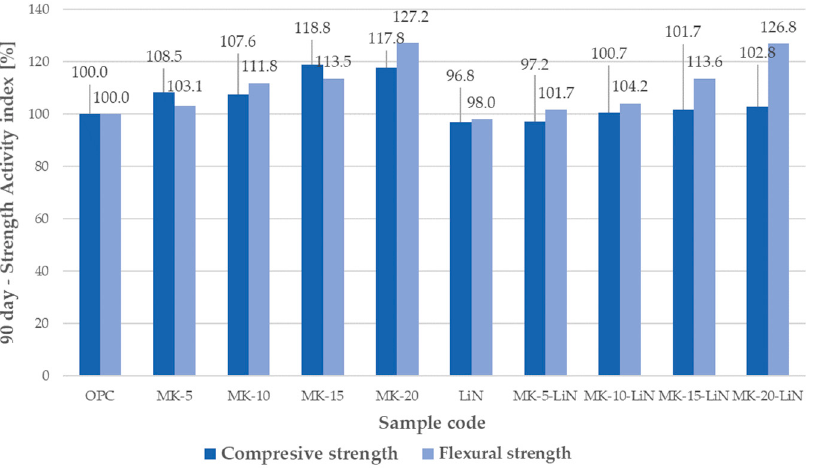
Figure 2. Strength activity index of mortars containing metakaolin and lithium nitrate at 90 days.